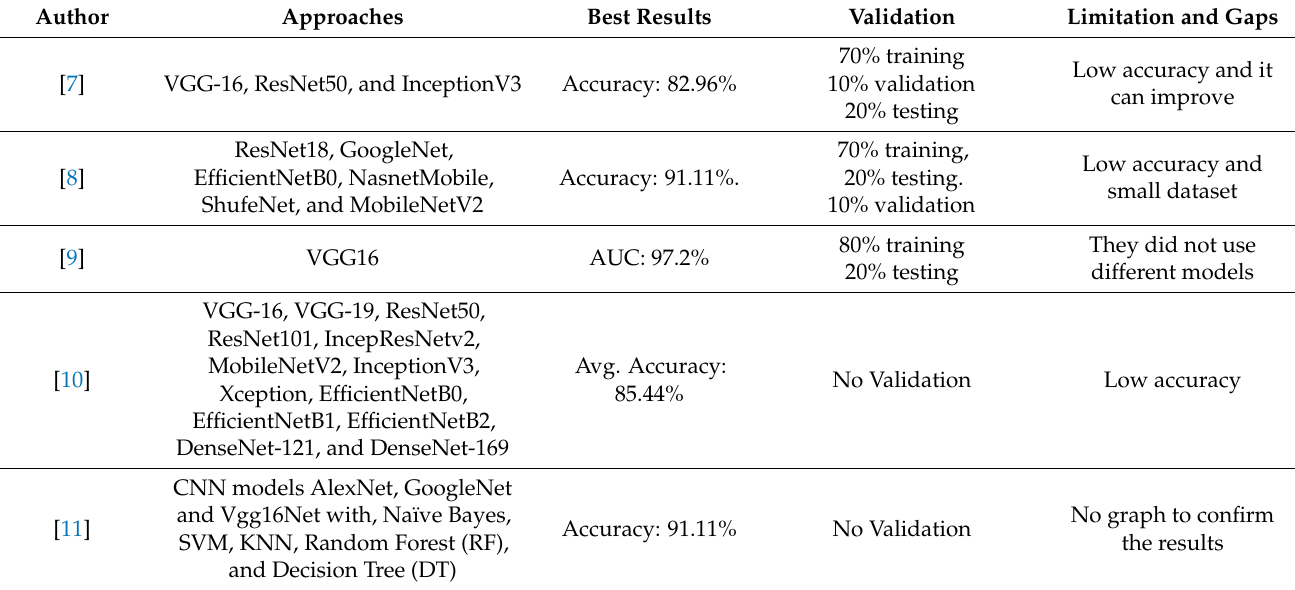
Table 1. Summary of work related to mpox